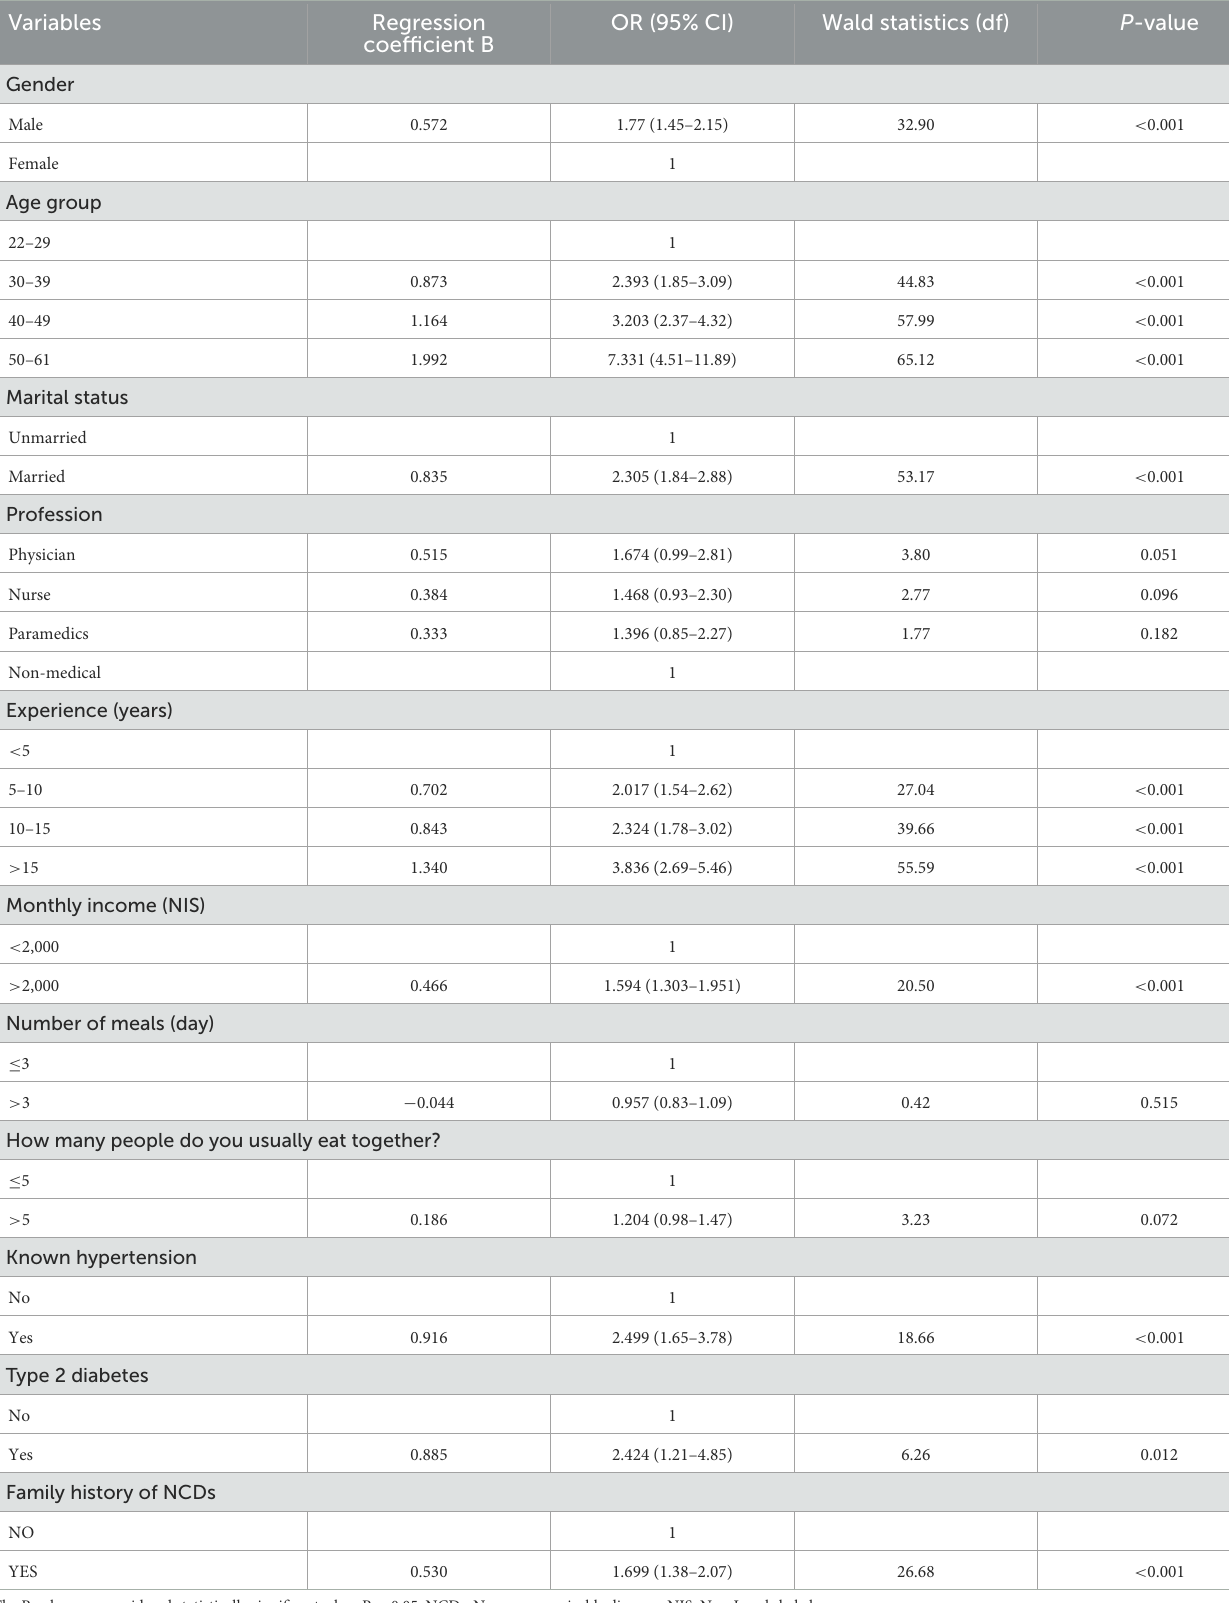
TABLE 3 The association between HCWs’ overweight and obesity and associated factors. Variables Regression OR (95% CI) Wald statistics coefficient B